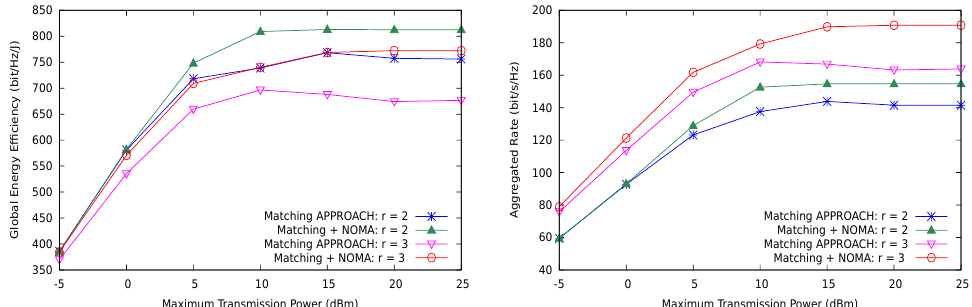
Figure 9. Global energy efficiency and aggregated rate with the matching theory based solution vs. NOMA for the shared CUs case.